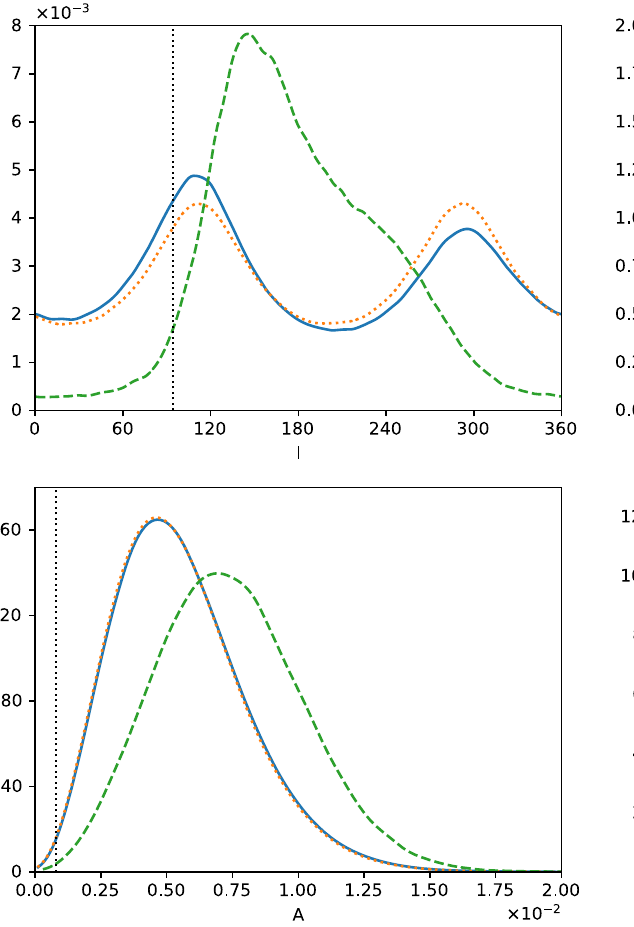
Fig. 7 Blue lines show marginalized likelihoods of dipole A , monopole B and ( l , b ) forJLAdataset,andblackverticallinesrepresent best-fitting values. Orange dotted lines represent results of “isotropic”